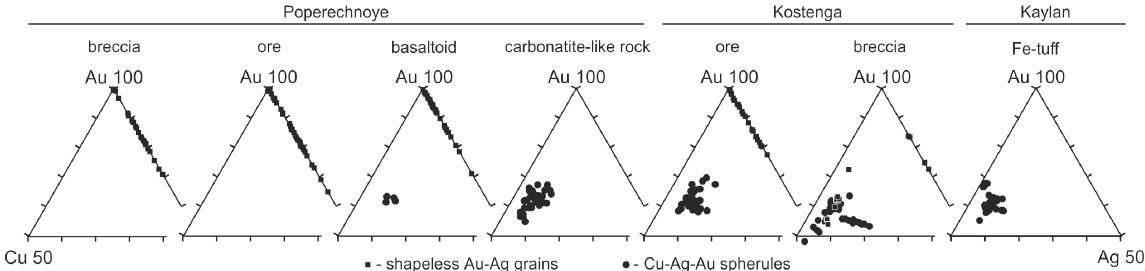
Figure 8. Composition of gold alloys from the three Lesser Khingan Range LKR Fe-oxide deposits and associated volcanic rocks.